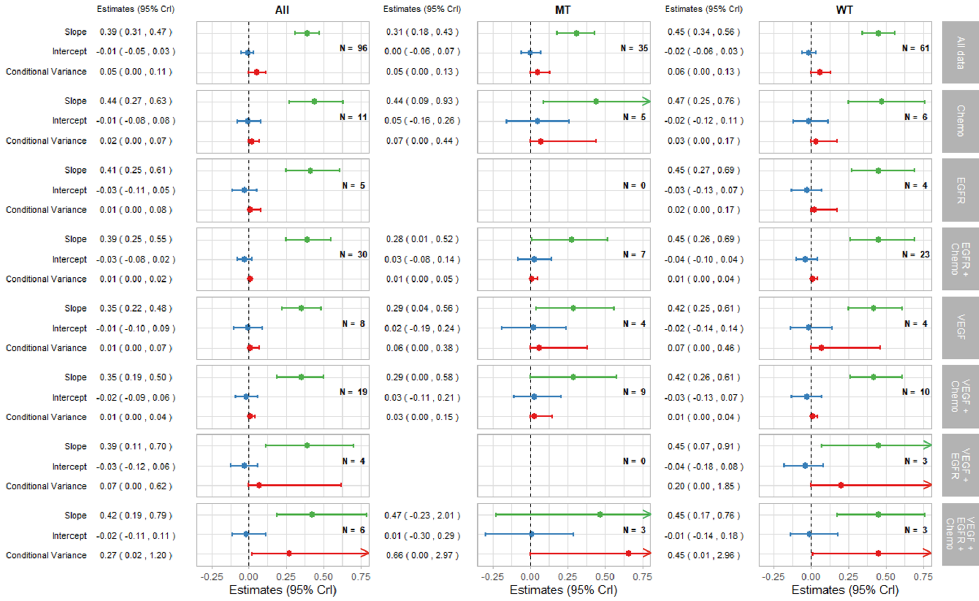
Figure 3. Forest plot of estimates of slope (green), intercept (blue), and conditional variance (red) for PFS as a surrogate for OS. N represents the number of trial-subgroups. CrI = Credible Interval.